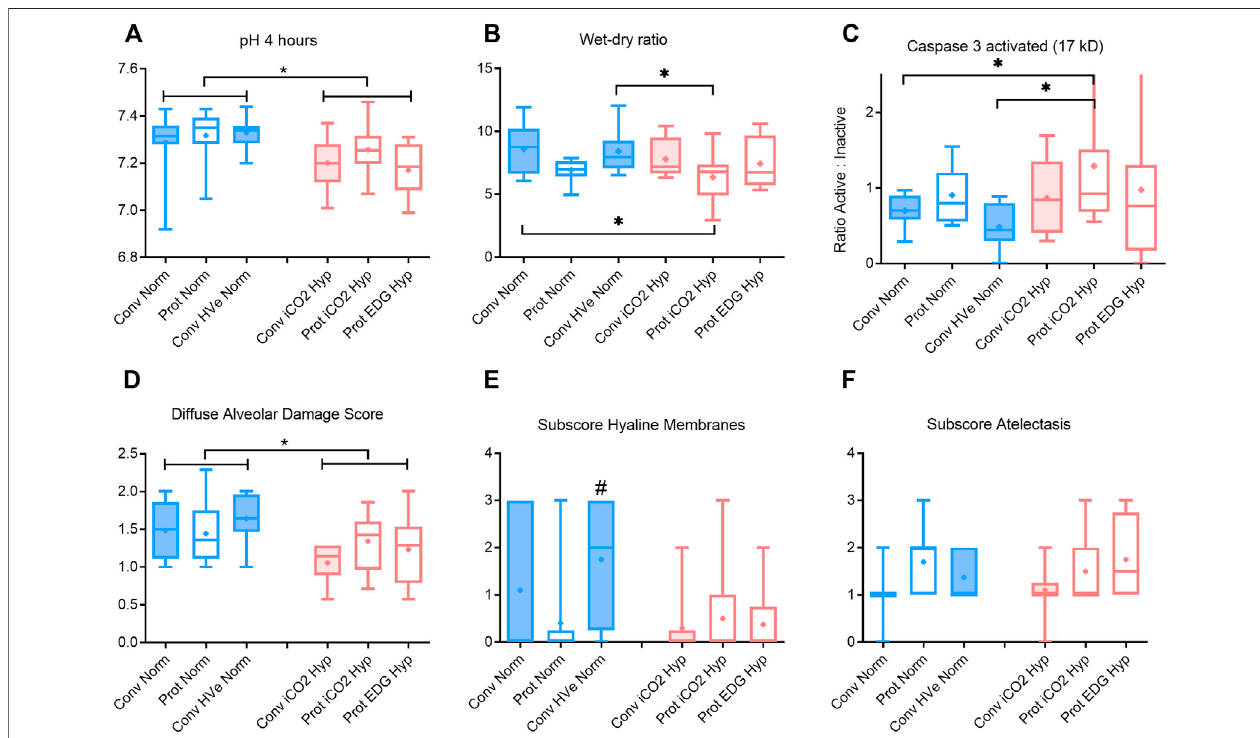
FIGURE 2 | pH, wet-dry ratio, caspase activation and alveolar damage scoring after 4 h of ventilation boxplot of IQR, mean, median, min-max (whiskers). Closed boxes: high tidal volumes; open boxes: low tidal volumes; blue color: normocapnia; red color: hypercapnia. * denotes signi fi cant differences between groups # denotes signi fi cant difference to all other